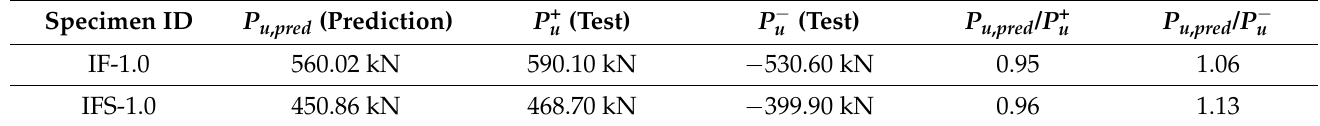
Table 7. Prediction of maximum force for IF-1.0 and